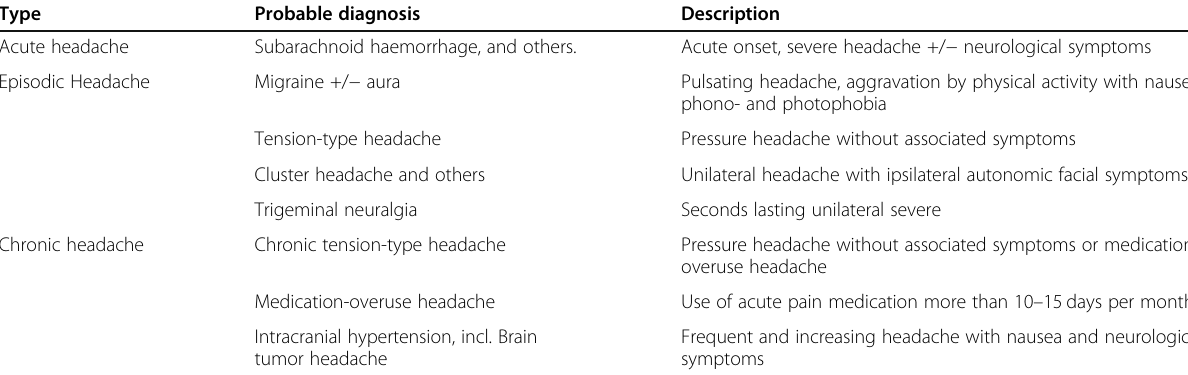
Table 1 The most important types of headache and facial pain